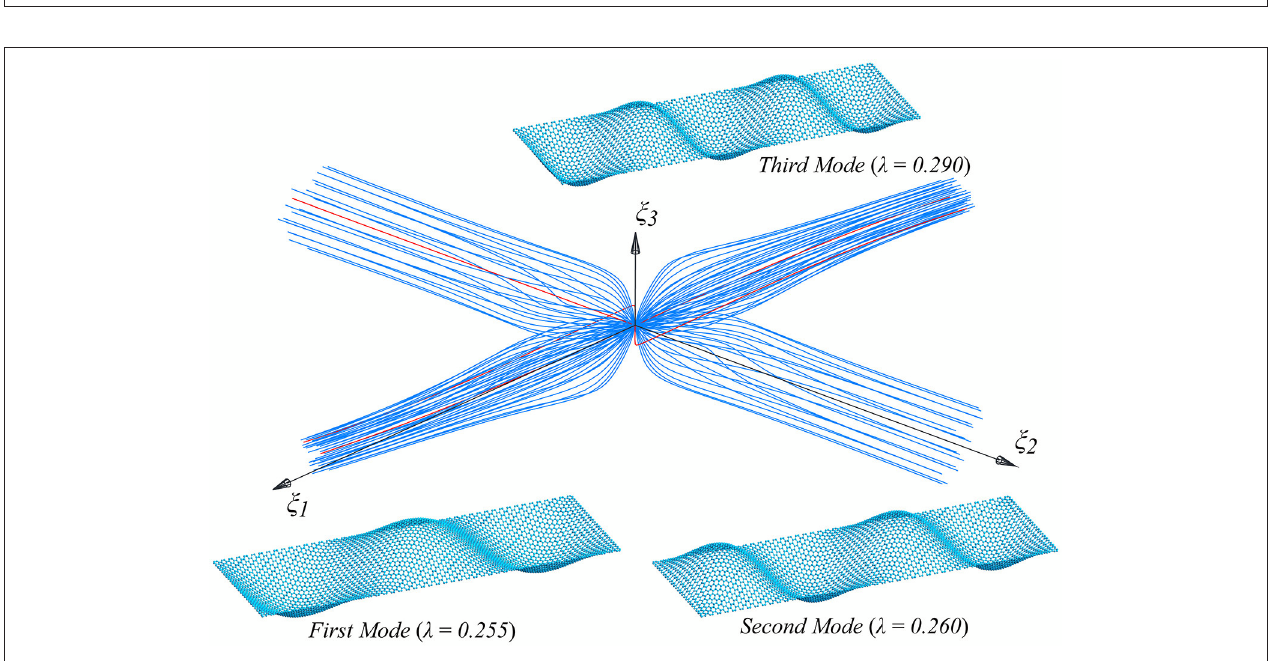
FIGURE 9 | Supported graphene strips under compression in the zigzag direction: first three buckling modes and their interaction.